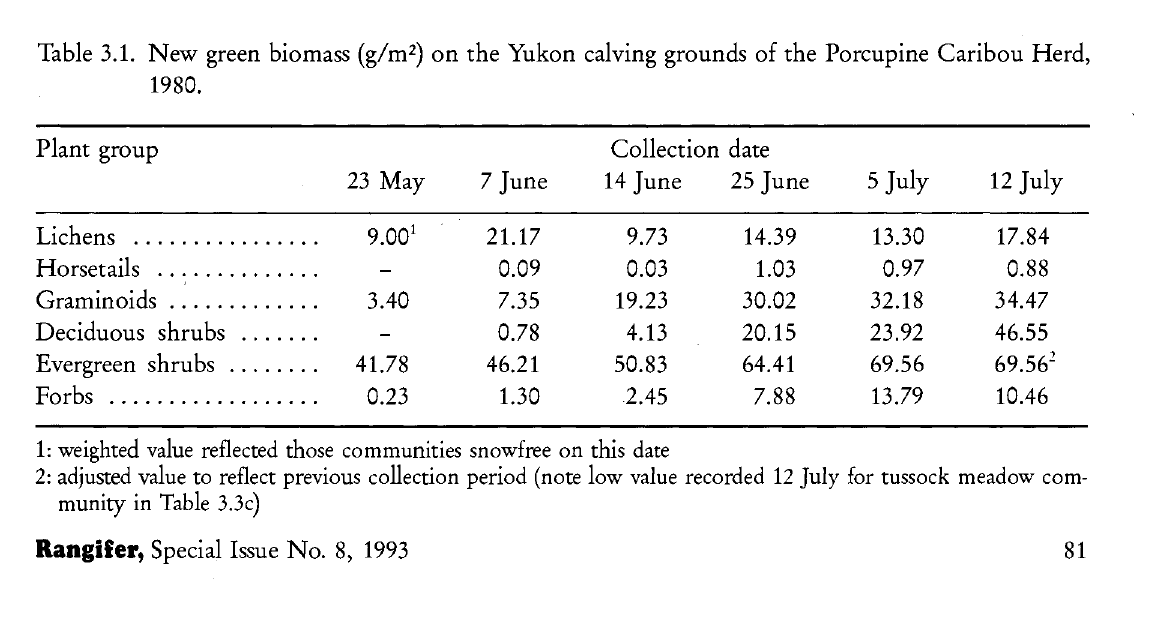
cupine caribou calving grounds, 1979-81.